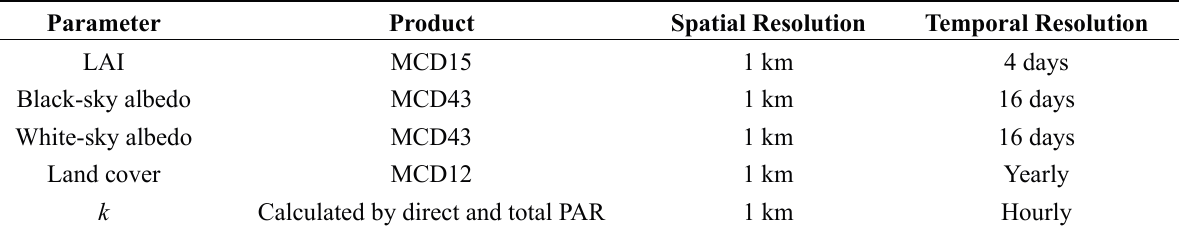
Table 2. Input data for FPAR inversion.